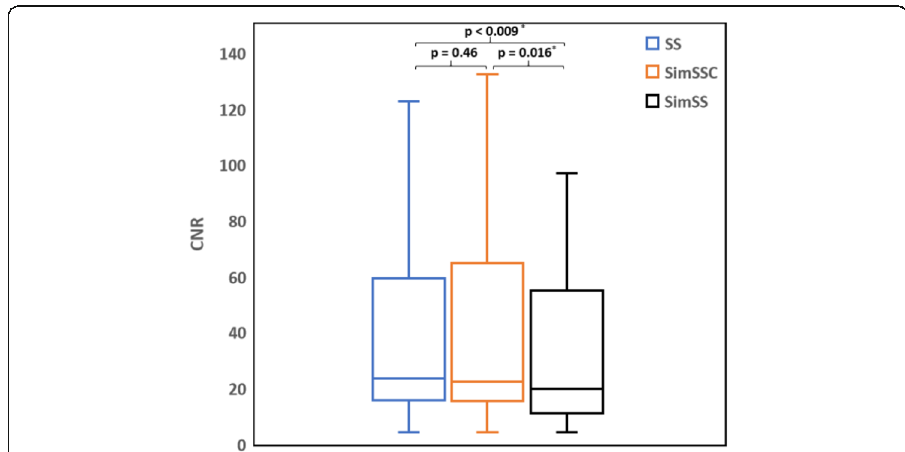
Fig. 6 Box plot on contrast-to-noise ratio for two acquisition modes (SS, step-and-shoot; SimSSC, simulated step-and-shoot continuous; SimSS, simulated step-and-shoot). The median is illustrated by the midline, first and third quartiles by the lower and upper lines of the box, and extremes by